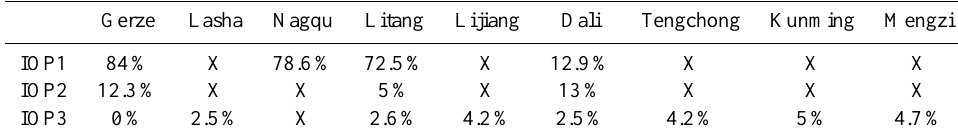
Table 2. Frequency of multiple tropopause (MT) during the three observation periods.